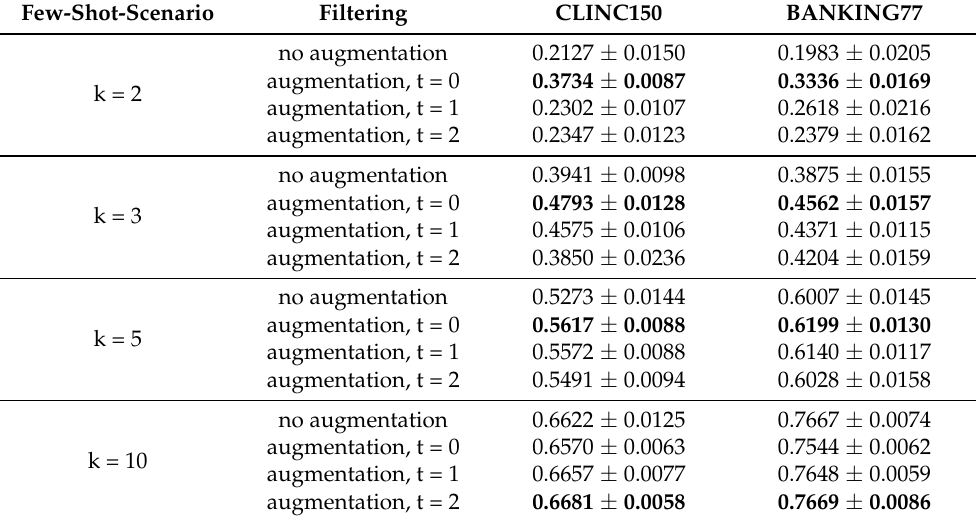
Table 5. Mean accuracy and standard deviation obtained for the corpus augmentation method in the few-shot scenario. In each augmentation setup, t denotes the stop word (SW) filtering threshold. Note: bold marks the model with the highest mean